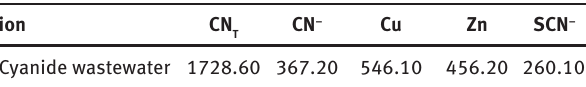
Table 2: Ionic components of cyanide wastewater (mg/L).